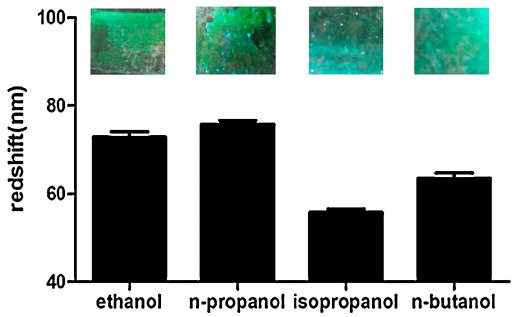
Figure 5. The red shift and structural color of 3DOCs in different alcohols. Reproduced with permission from [29].